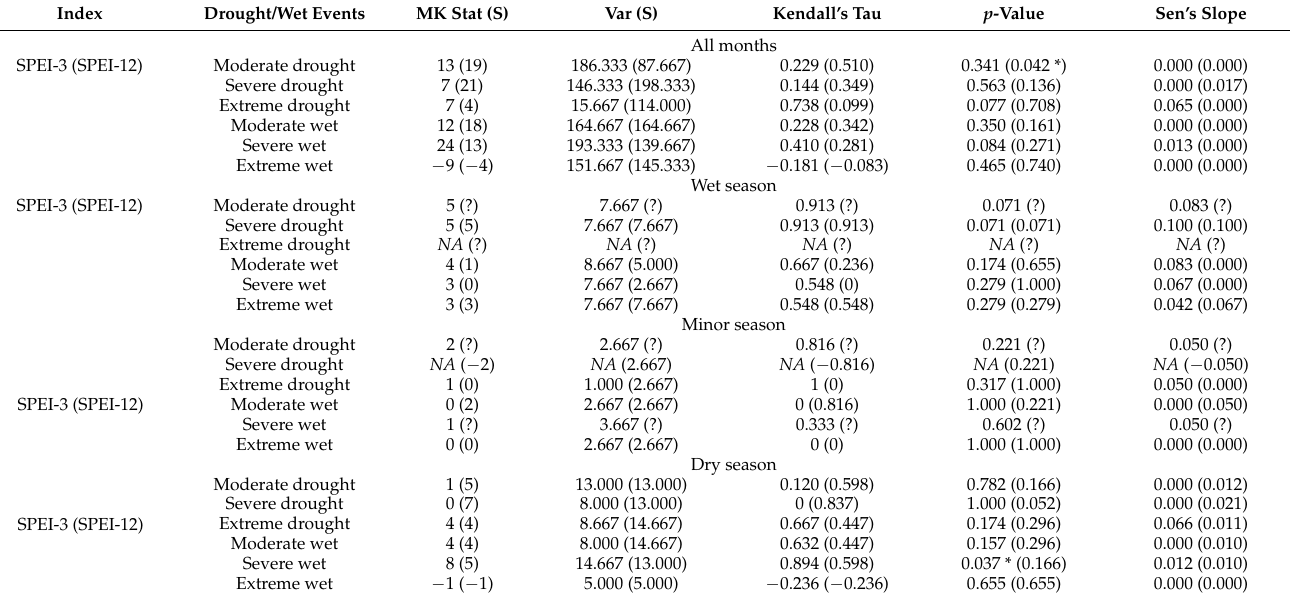
Table 2. Mann–Kendall trend test and Sen’s slope estimate for seasonal drought and wetness events from